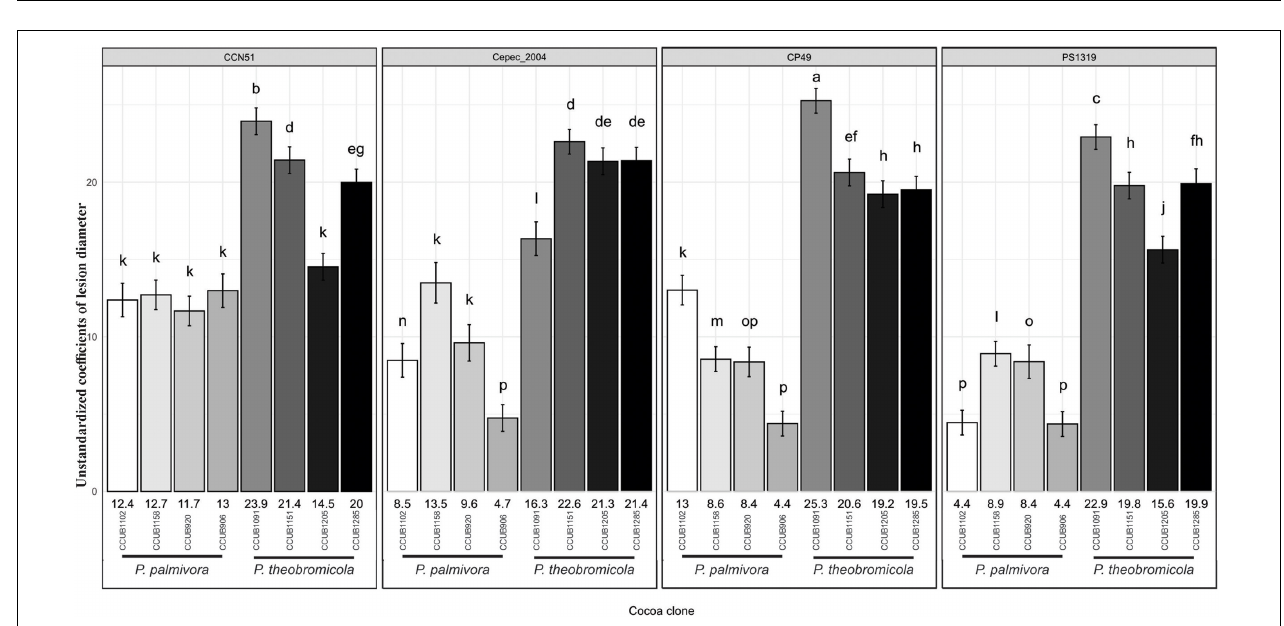
FIGURE 7 | Growth rates of necrotic lesion development induced by Phytophthora species on different cacao genotypes. Vertical axis synthesizes mean ( ± SE) values of unstandardized coefficients generated through linear mixed-effects model. Letters above the error bars indicate statistical significance (95% confidence interval) of global comparisons among coefficients. Numbers at the bottom of each bar represent the mean coefficient values for individual Phytophthora theobromicola and Phytophthora palmivora isolates.